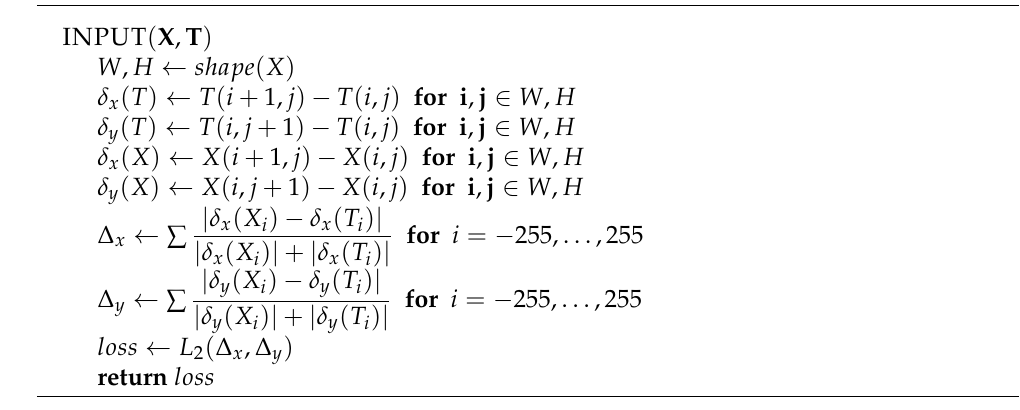
Figure 7. Image gradient response. ( a ) is the image gradient of Figure 6a (red) compared to the clean image (blue). ( b ) is the image gradient of Figure 6b (red) compared to the clean image (blue). ( c ) is the image gradient of Figure 6c (red) compared to the clean image (blue). Note that the extracted features clearly differentiate each noise type. Algorithm 1 Algorithm for the loss function to estimate the noise